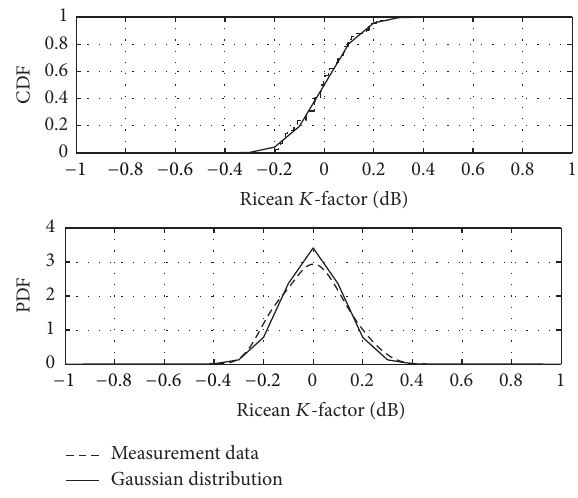
Figure 10: CDF and PDF of the measured Ricean 𝐾 -factor, together with a Gaussian fit.